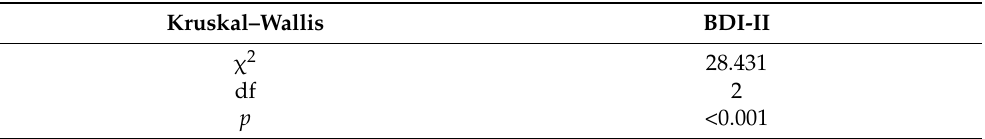
Table A6. Testing for significant group differences in the Beck Depression Inventory-II (BDI-II) using the Kruskal–Wallis test. Abbreviations: BDI-II, Beck Depressions Inventory-II; df, degree of freedom; p , asymptotic significance; χ 2 , chi-square.